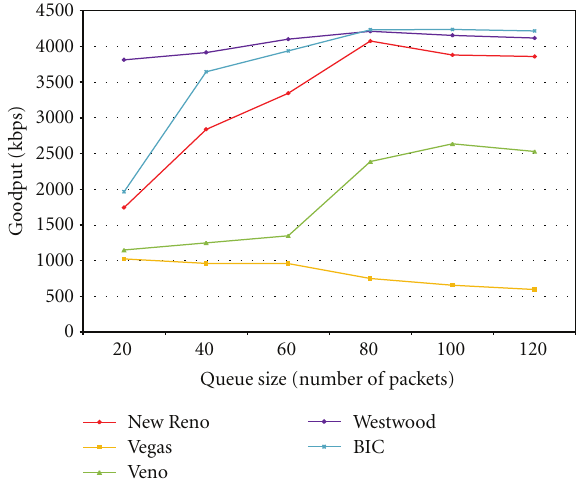
Figure 14: Goodput versus PER for Scenario 1. A single TCP flow in a WiFi network.